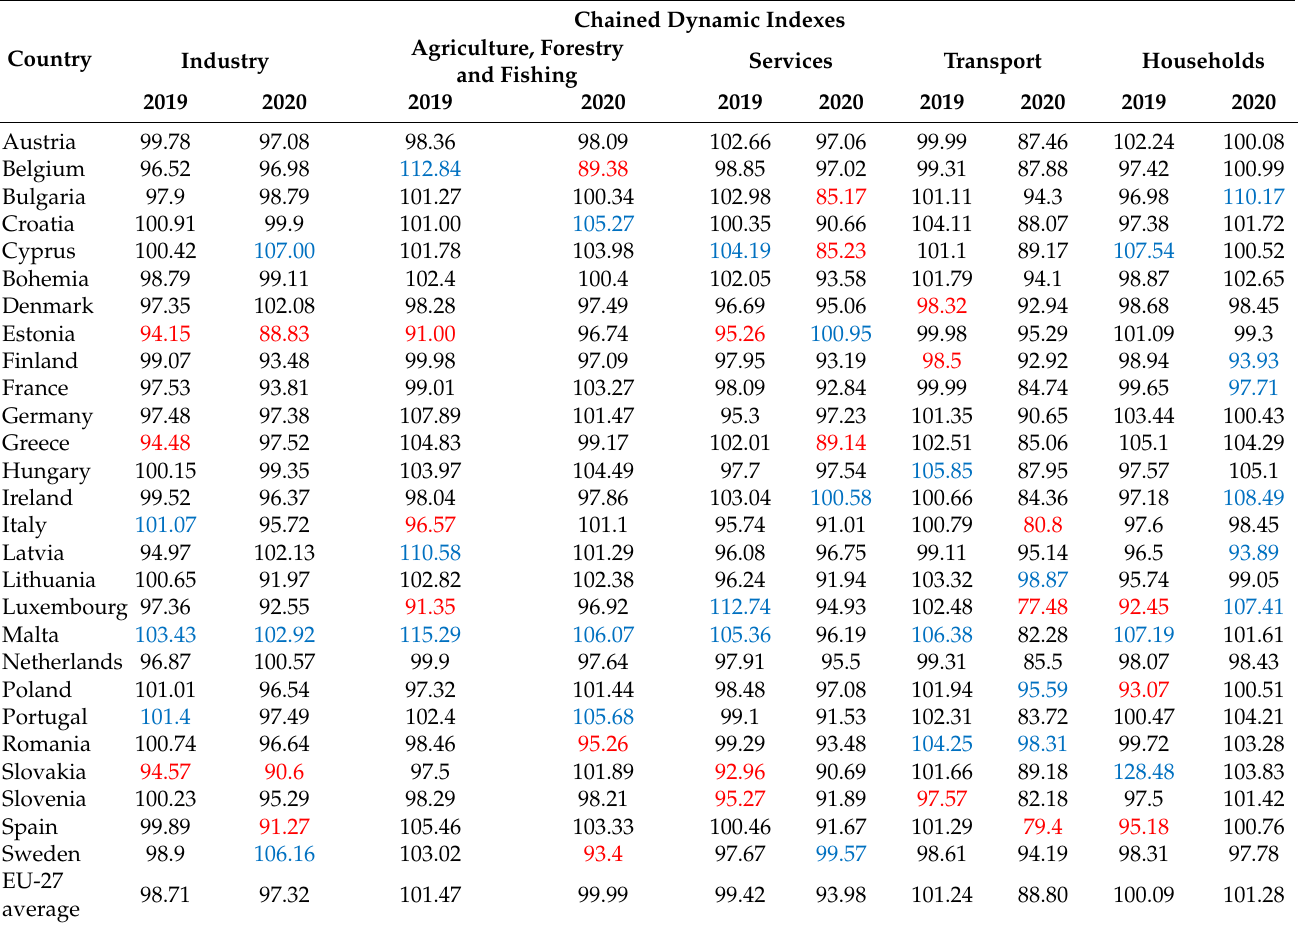
Table 3. Dynamics of change in final energy consumption by sector and area in EU countries from 2005 to 2020. Blue indicates the three best performers in a given sector and period, and red the three worst